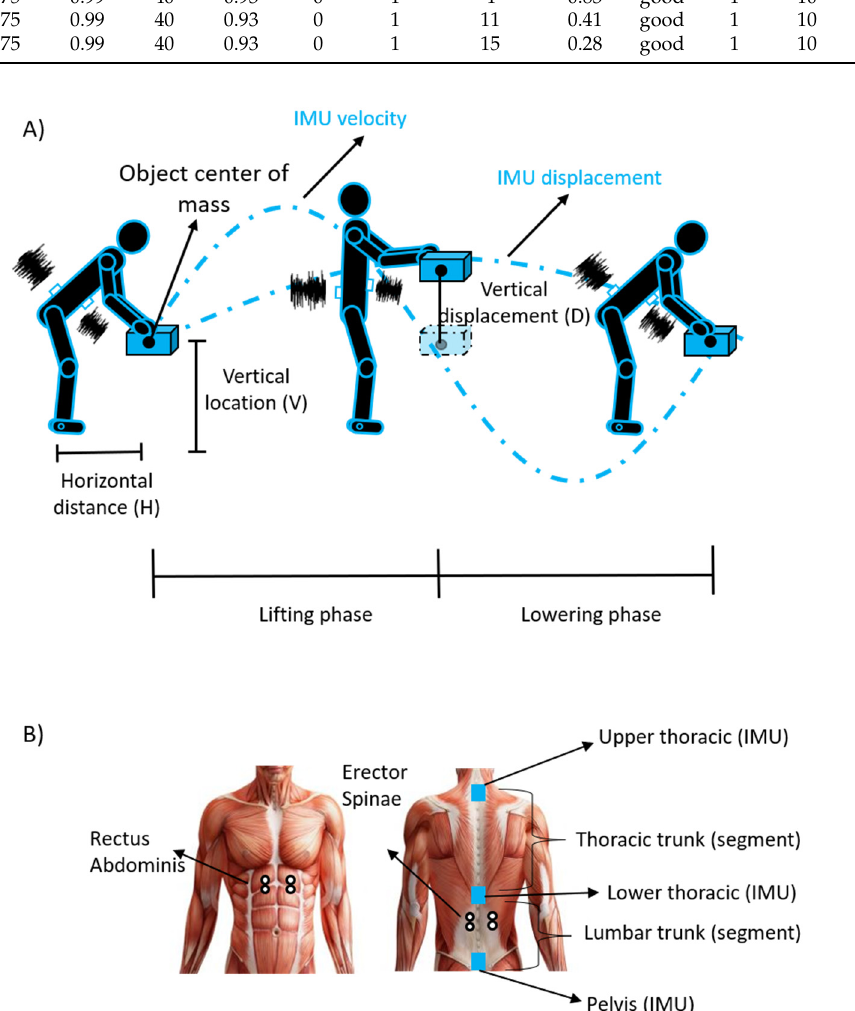
Figure 1. ( A ) description of the experimental setup and of the lifting cycle: displacement and velocity of the IMU placed on the load were used to define the lifting and lowering phases (see Section 2.5.1 for further details). ( B ) Locations of the IMU (blue squares) and sEMG (white circles) elec- trodes.